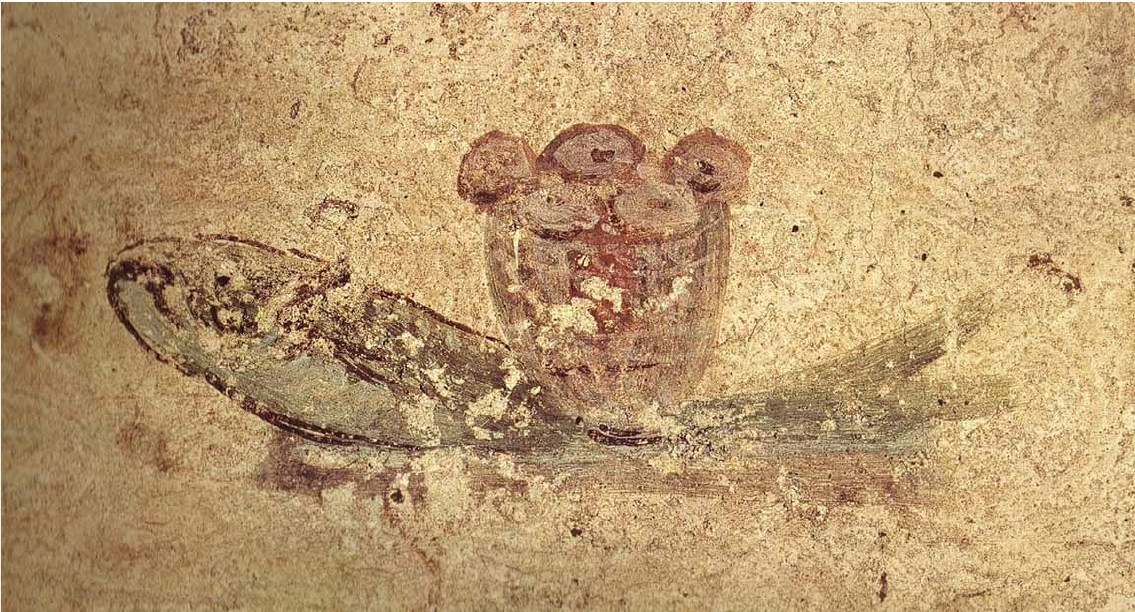
Figure 2. Eucharistic Fish and Loaves. A fresco of the catacombs of St. Callistus, Rome. 2nd–4th century CE. https://www.wikiwand.com/ru/ (accessed on 16 May 2022).